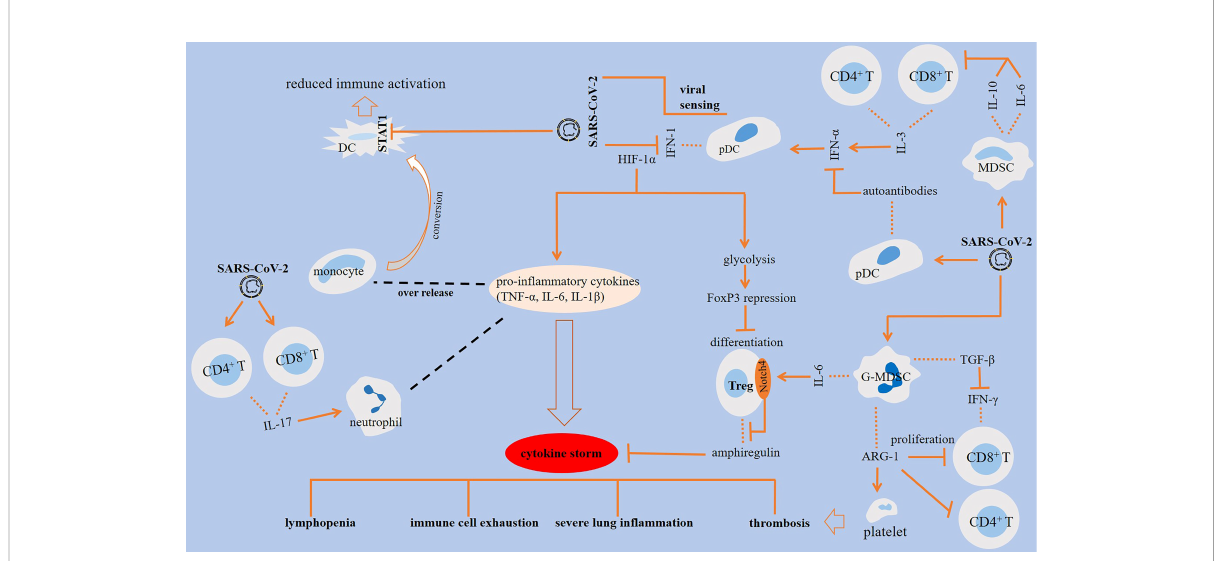
FIGURE 1 Interactions among cells of the immune system in SARS-CoV-2-induced disease. SARS-CoV-2 antagonizes STAT1 phosphorylation, which is linked to the reduced immune activation in monocyte-derived dendritic cells (DCs). The impact of SARS-CoV-2 on DCs results in the production of autoantibodies against interferon (IFN)-1. Activation of CD8 + T cells is essential for virus clearance, and the activity of CD4 + T cells is important for the activation of CD8 + T cells and optimal antibody responses. IL-3 released from CD4 + and CD8 + T cells stimulates IFN- a , which is further linked to the higher fraction of plasmacytoid DCs (pDCs). The effector activity of T cells is suppressed by SARS-CoV-2 inducible effect on myeloid-derived suppressor cells (MDSCs) and further release of ILs 6 and 10 from the cells. IL-6 stimulatory effect on Notch4 expression from regulatory T cells (Tregs) contributed to severe lung in fl ammation via hampering release of amphiregulin. Granulocytic (G)- MDSCs also suppress the proliferation of T cells through the release of arginase-1 (ARG-1), which contributed to lyphocytopenia. ARG-1 activity and the resultant low L-arginine level contributed to platelet activation and thrombosis. In addition, MDSCs block IFN- g production from T cells through releasing transforming growth factor (TGF)- b